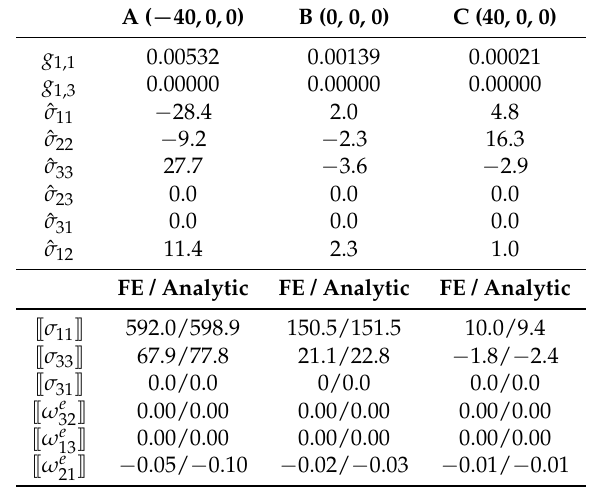
Table 2. Values of ˆ σ (MPa) and ∇ g provided by the FE simulation 2 and used to compute the analytic ∼ formulas (28)–(30) and (32) (top). Comparisons of the values of [[ σ simulation 2 and those computed from the analytic formulas (bottom).